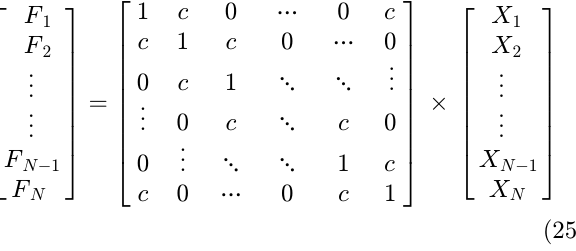
Fig. 6. The block diagram of load distribution calculations for the